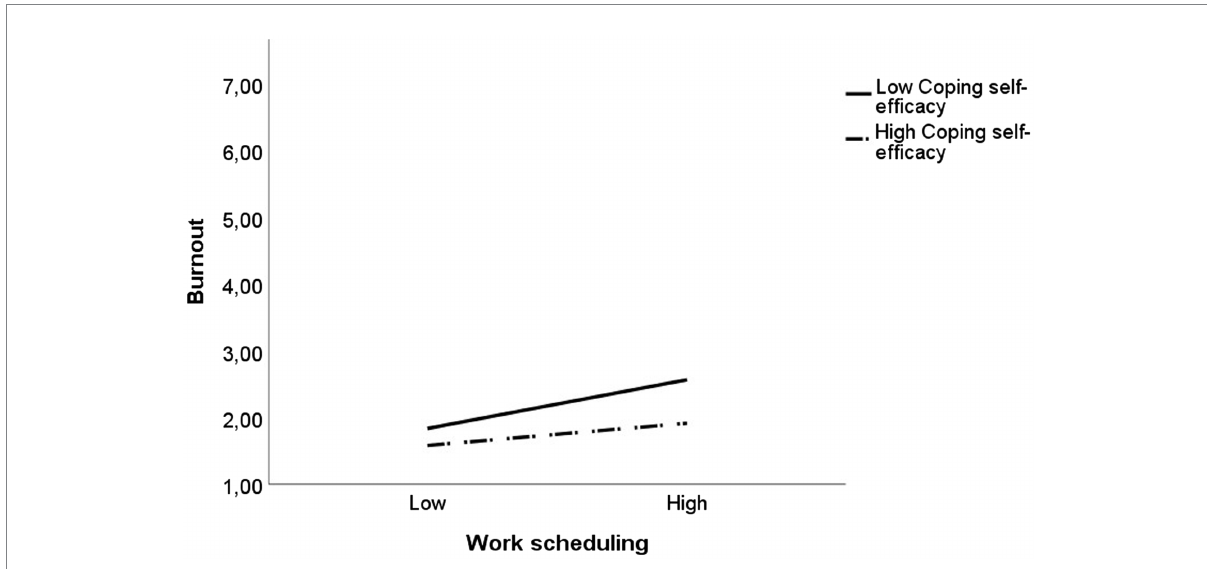
FIGURE 2 Moderating effect of coping self-efficacy on the relationship between work scheduling and burnout. All predictors in this figure are centred and standardised and measured at T1. Predictor levels: Low = 1 SD below the mean, High = 1 SD above the